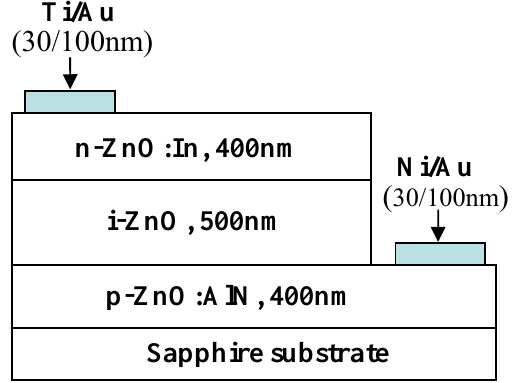
Figure 22. Schematic of the light-emitting diodes p -ZnO:AlN/ i -ZnO/ n -ZnO:In. Reprinted from Ref. [158] with permission.